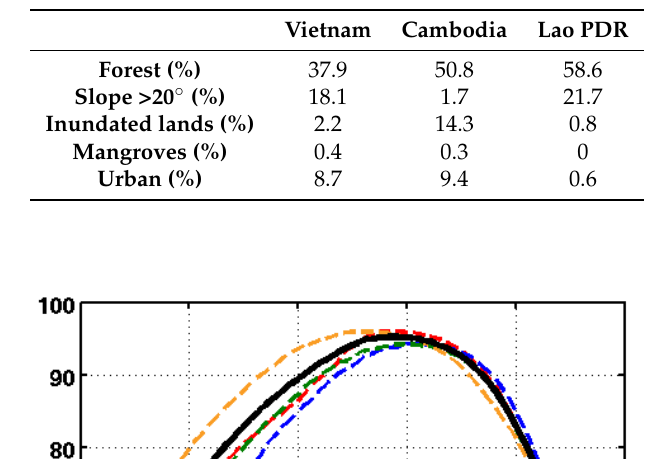
Table 2. Masking process results over Vietnam, Cambodia and Lao PDR. Forest and non-forest areas were first separated, and then, terrain slopes 20 ◦ , inundated lands, mangroves and urban areas were filtered out.